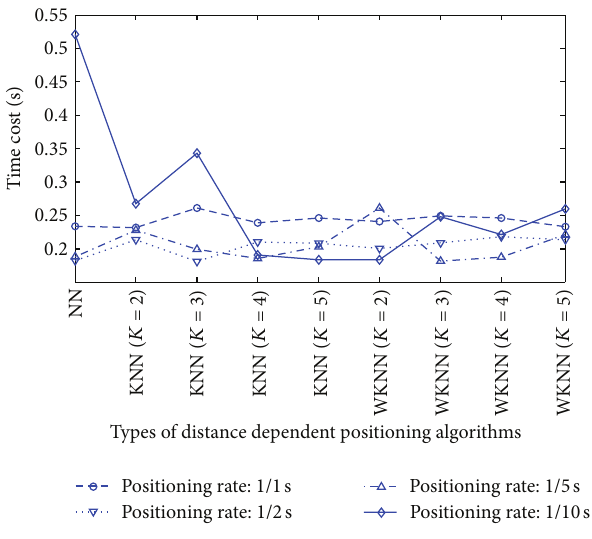
Figure 17: Time cost for each position calculation.